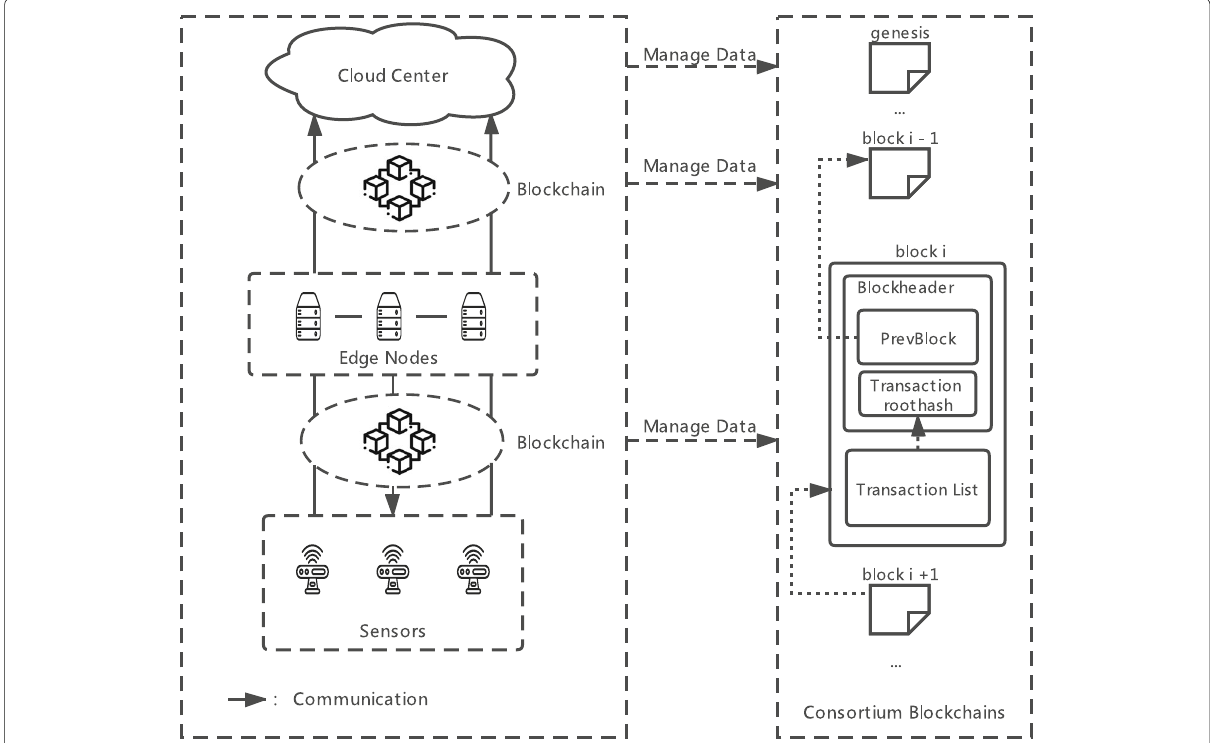
Fig. 1 The architecture of edge computing of different components of